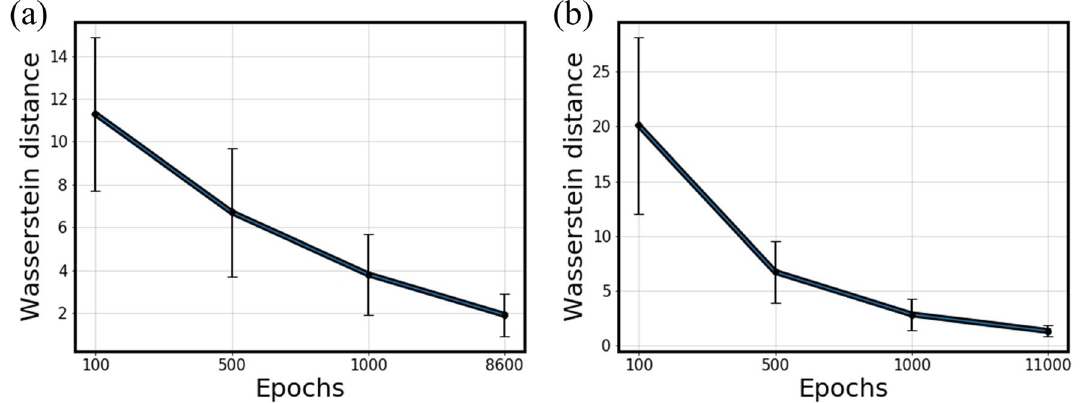
Figure 8. Average Wasserstein Distances at different epochs. ( a ) Steel E. ( b ) Steel F.